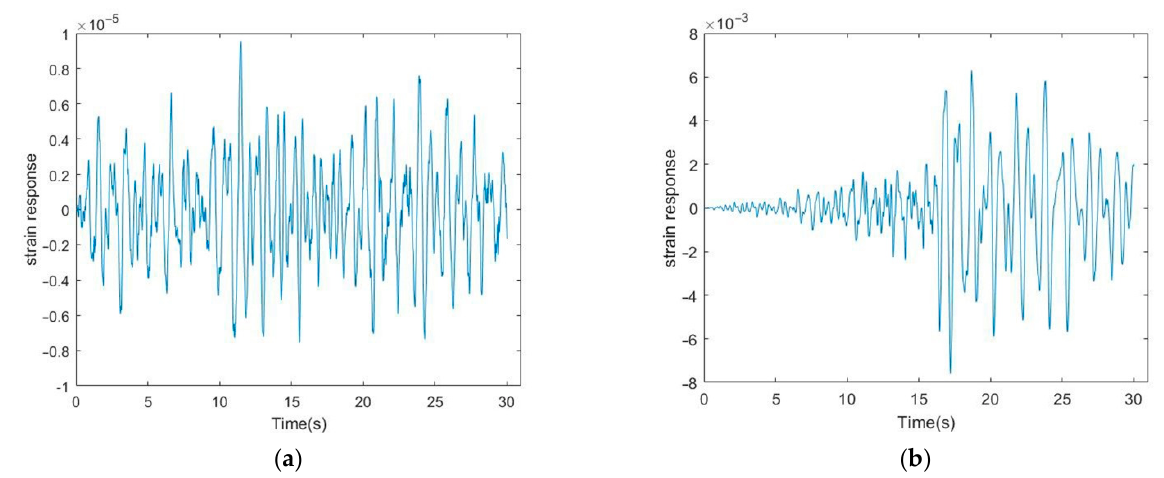
Figure 7. ( a ) Time history of strain response in the 69th element under ambient excitation; ( b ) time history of strain response in the 69th element under Chi-Chi earthquake.